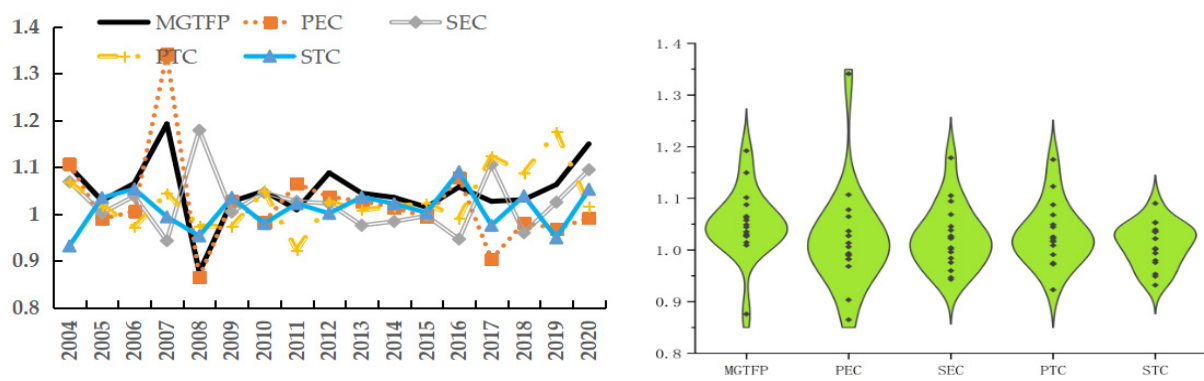
Figure 4. The Zofio index decomposition of mariculture.